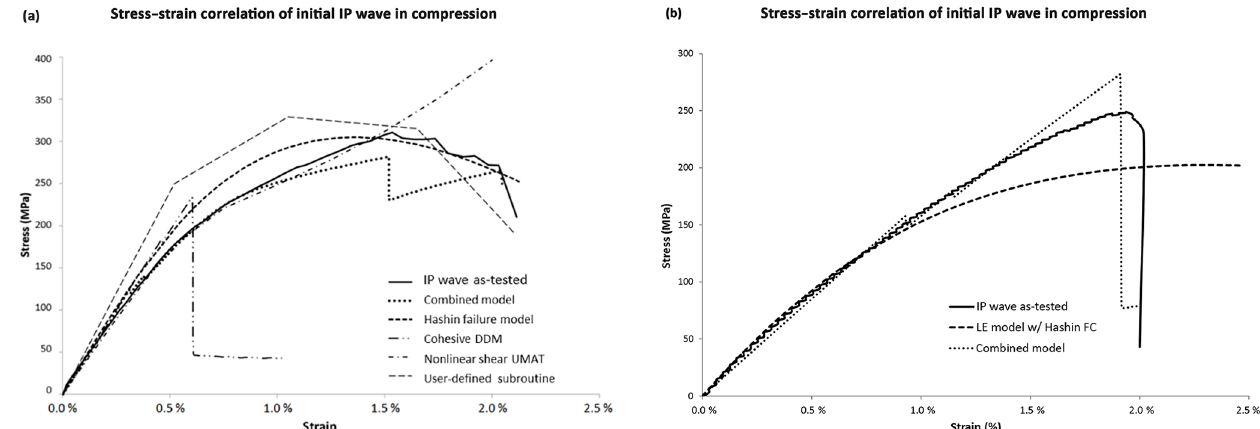
Figure 10. Resulting initial IP wave tension (a) and compression (b) stress–strain curves of each model compared to experimental